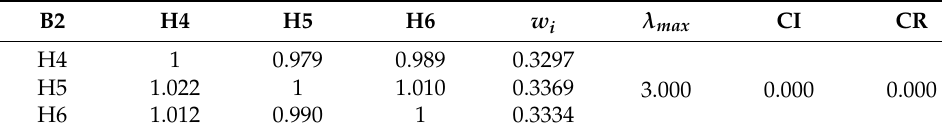
Table 8. PEOU judgment matrix and weight values.